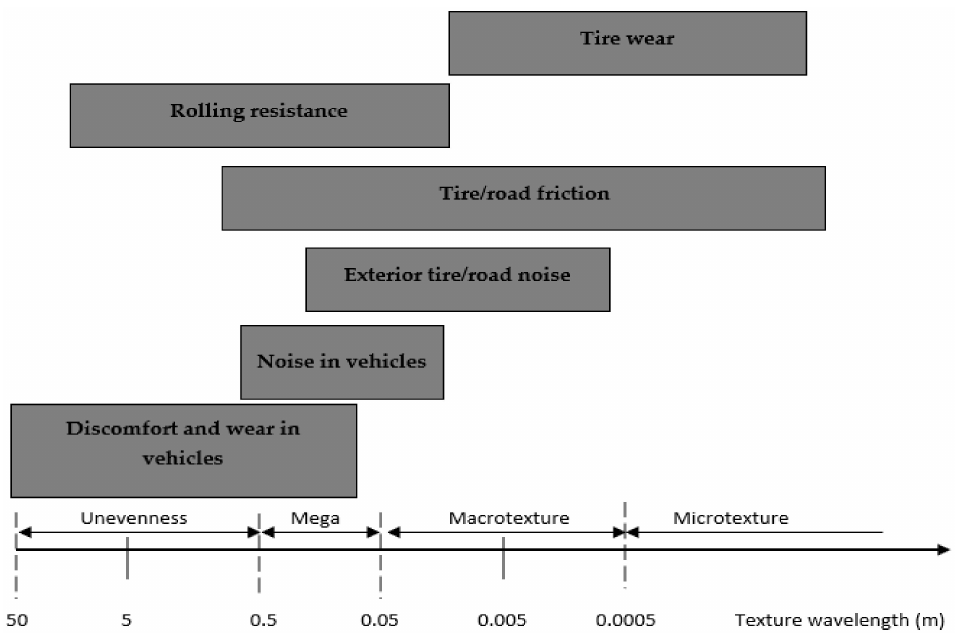
Figure 1. Tire-pavement interactions and ranges of the texture wavelength and spatial frequency (adapted from